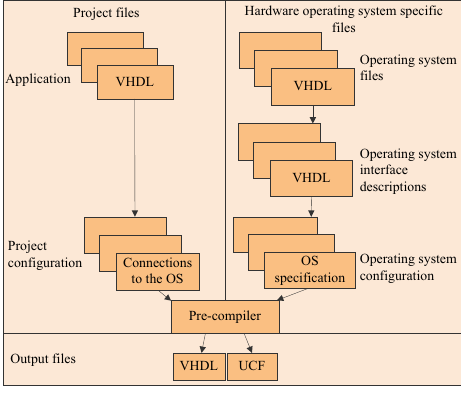
Figure 1: Workflow of the hardware operating system.